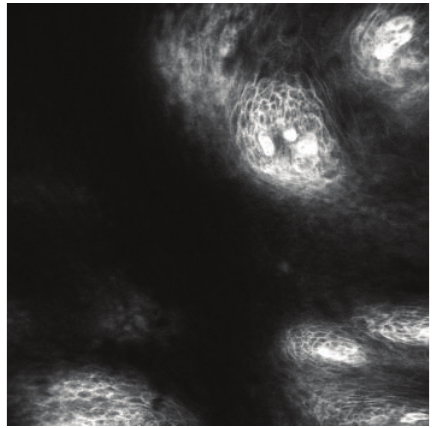
Figure 3: CLE image of the treated esophageal area, middle portion. Normal squamous esophagus showing individual epithelial cells and intrapapillary capillary loops.